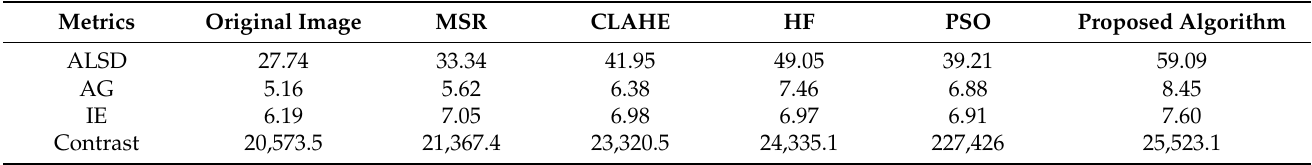
Table 3. Comparison of Yale face image enhancement algorithms.